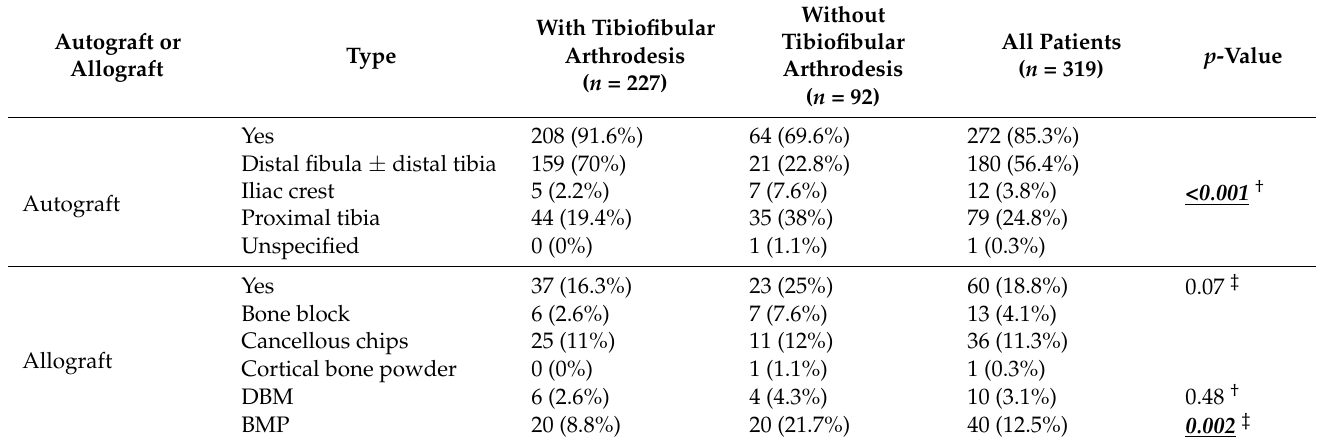
Table 6. Bone graft